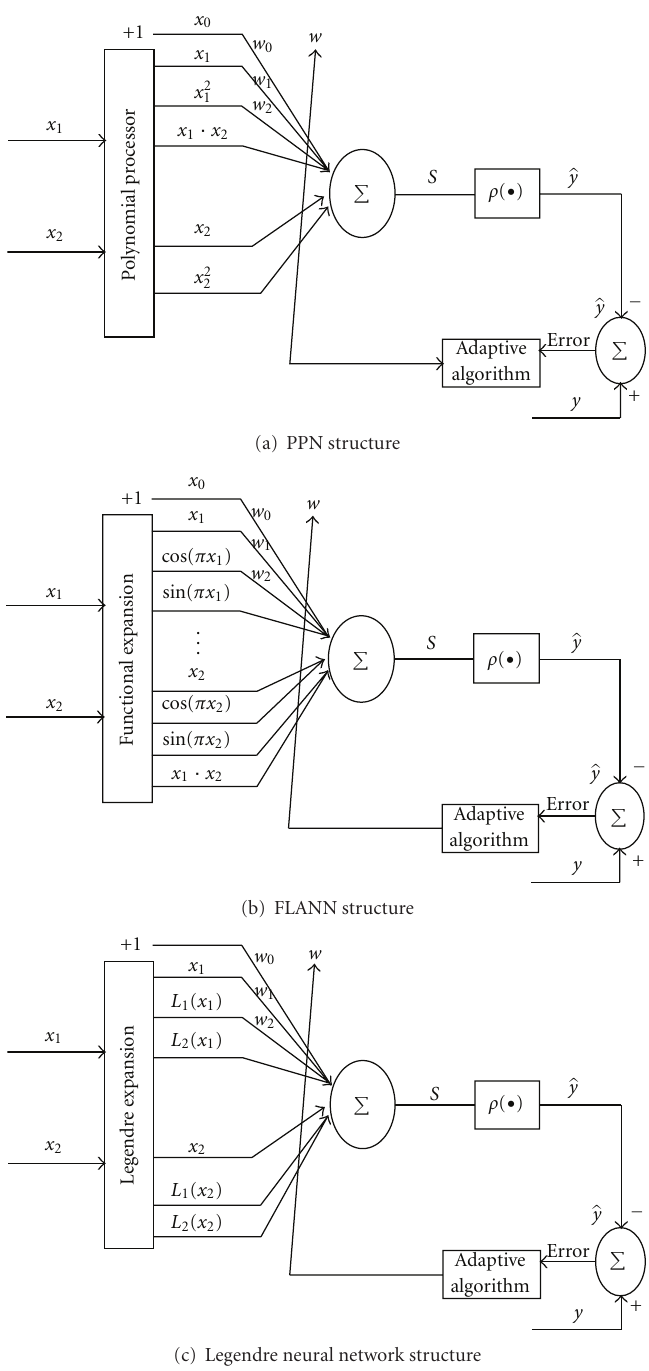
Figure 1: System architecture of function link based artificial neural